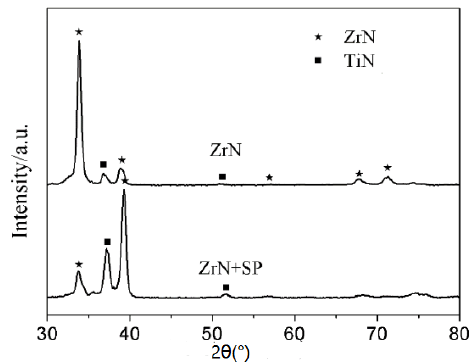
Figure 8. XRD results of the ZrN and ZrN+SP layers.